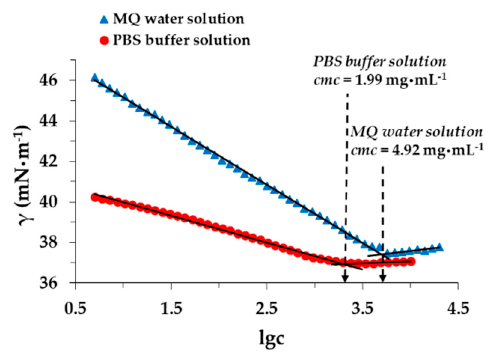
Figure 6. Determination of PLUR cmc at 25 °C in MQ water and in a PBS solution .